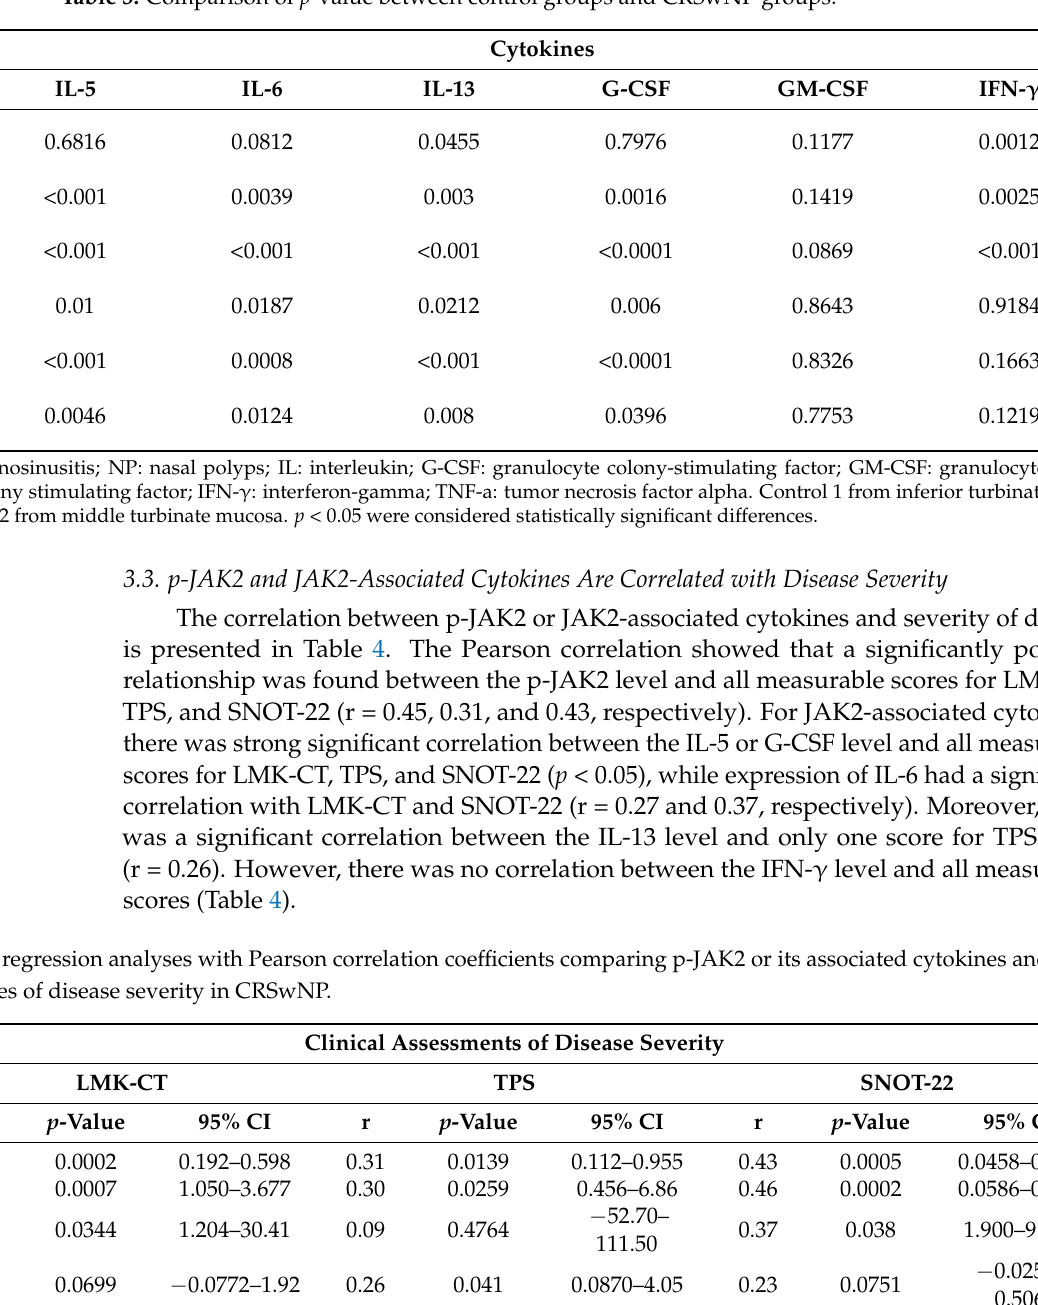
Table 3. Comparison of p -value between control groups and CRSwNP groups.